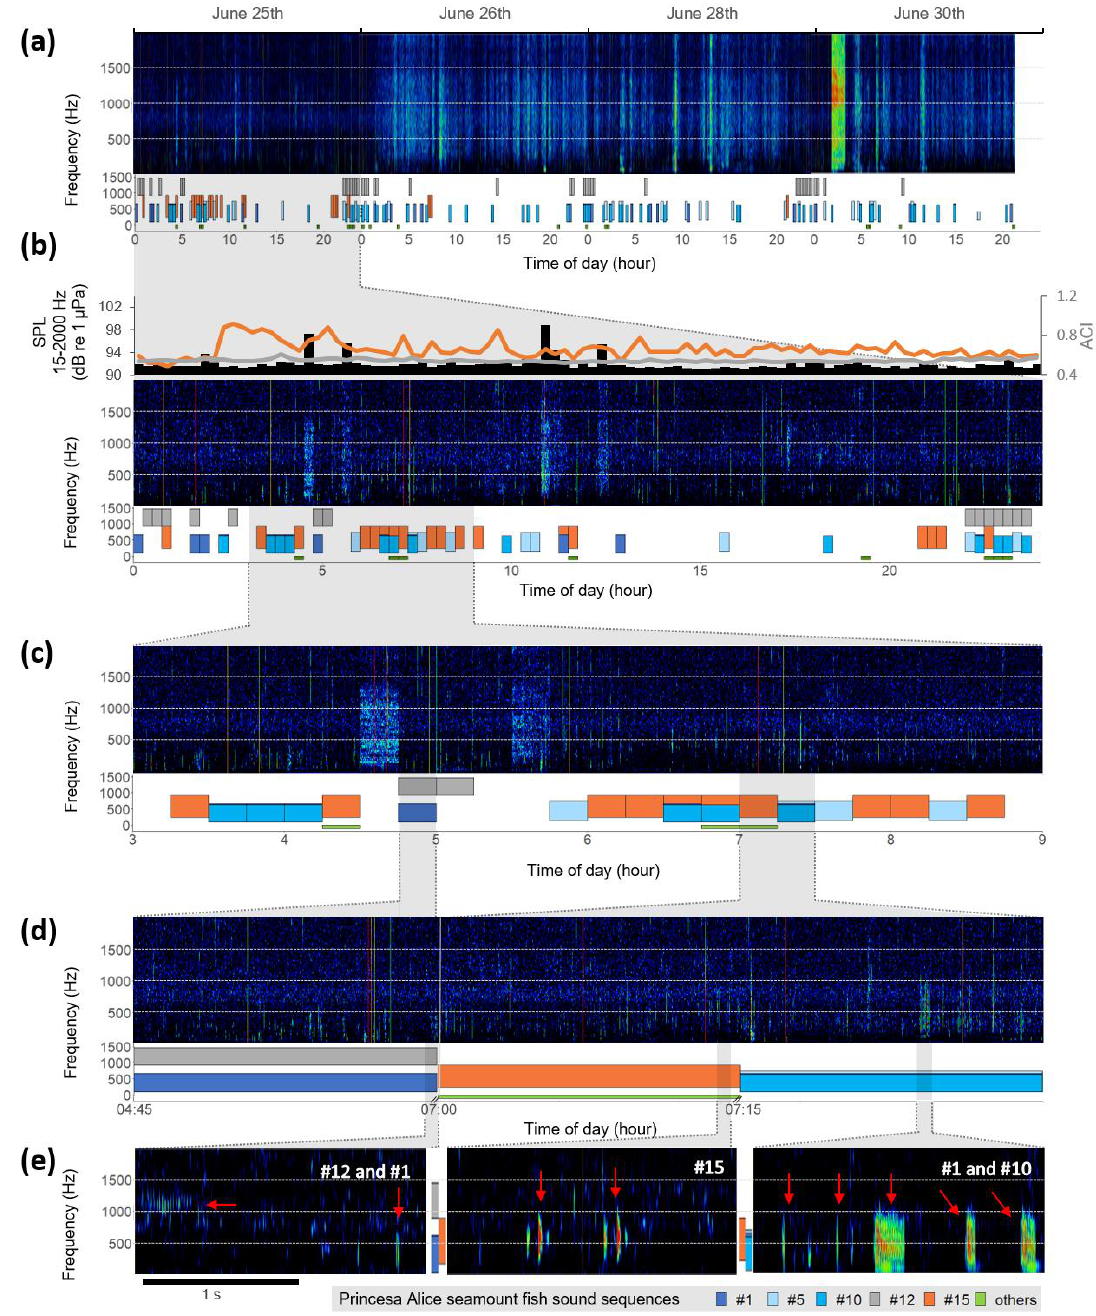
Figure 3. ( a ) Four-day long-term spectrogram from the Princesa Alice seamount (36 m deep) with segments expanded to 24 h ( b ), 6 h ( c ), 270 s ( d ) and 2 s ( e ). Note that the 2 s spectrograms ( e ) depict fish sound sequence types (#1, #10, #12, #15, reported in [23]). Sound acquisition was made 90 s every 900 s. Under each spectrogram the frequency range occupied by the most common fish sound sequences is represented. In ( b ), the SPL is presented for a 24 h period (25 June, black bars) for the frequency band 15–2000 Hz, the average SPL considering the 4 days is depicted by the orange line, and the mean ACI is also presented for the same frequency band by the grey line. Spectrogram settings: Sampling frequency: 8 kHz; FFT size: 512; window size: 512; window type: Hamming, 50%overlap; for the extensions to observe individual sounds, a FFT size of 512 and a window size of 64 were used. Arrows indicates the fish sound sequences ( e ).